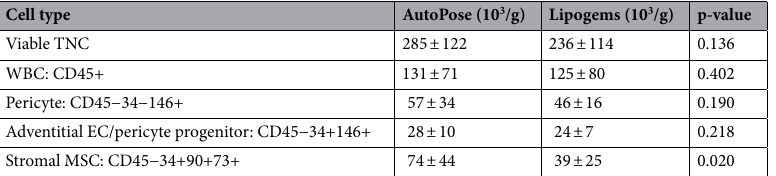
Table 2. Initial number of cells normalized per gram of enzymatically digested product (10 3 /g). Aggregate mean and standard deviation (SD) of data represented as “mean ±